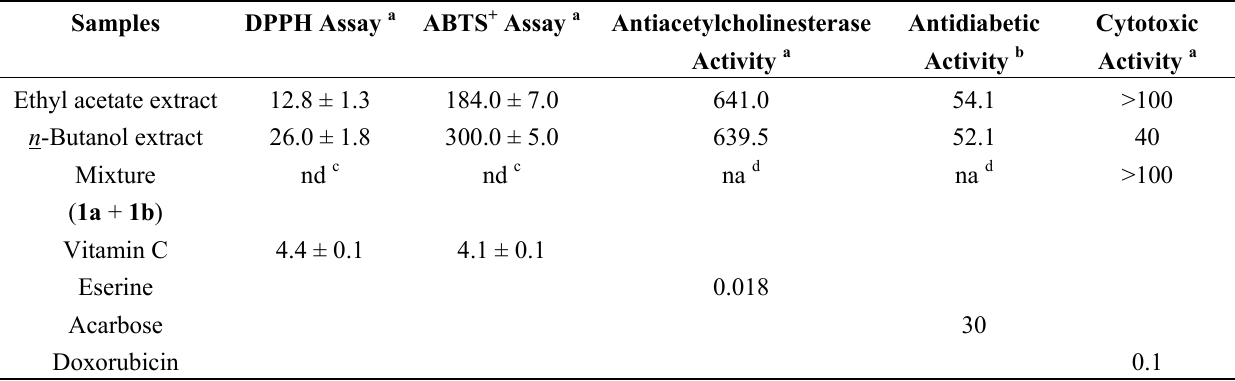
Table 4. Antioxidant, antiacetylcholinesterase, antidiabetic and cytotoxic activities of F. lutea extracts and the mixture ( 1a + 1b ).